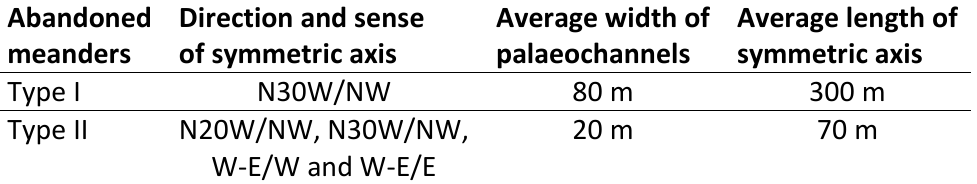
Figure 5. Details of abandoned meanders of low lands of the Jacaré-Guaçu River (ancient Araraquara). Details of the surface coverage of the low terraces on which the BES II site is located. Source: adapted from Cheliz (2013; 2016). See Table 2. Table 2. Essential attributes of abandoned